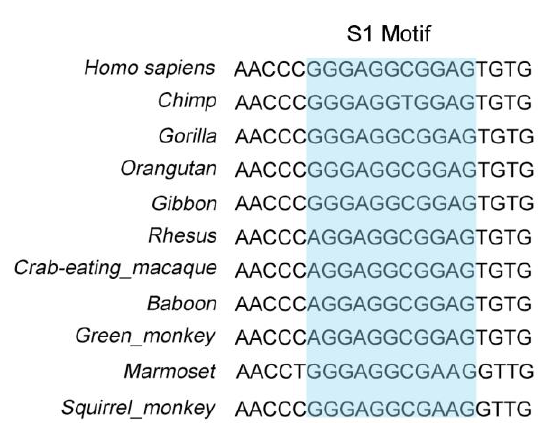
Figure 5. IGV visual analysis. Visual analysis of the PURα binding peak in the PCK2 promoter region